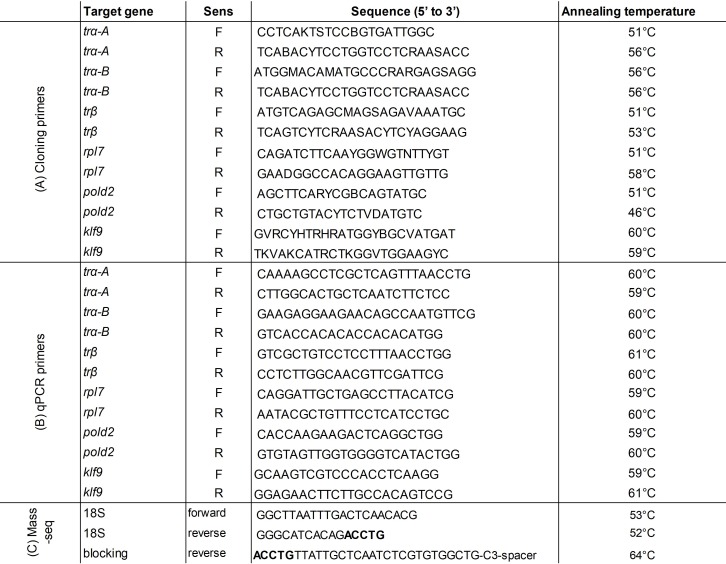
Primers used in this study.(A) Degenerated primers used for the cloning of the A. triostegus genes in this study. (B) qPCR primers used in this study. (C) Primers used for 18S mass sequencing. The overlapping nucleotides between 18 SR and the blocking primer are indicated in bold. The mean annealing temperature of each primer is indicated in the last column. See Figure 2—source data 6.